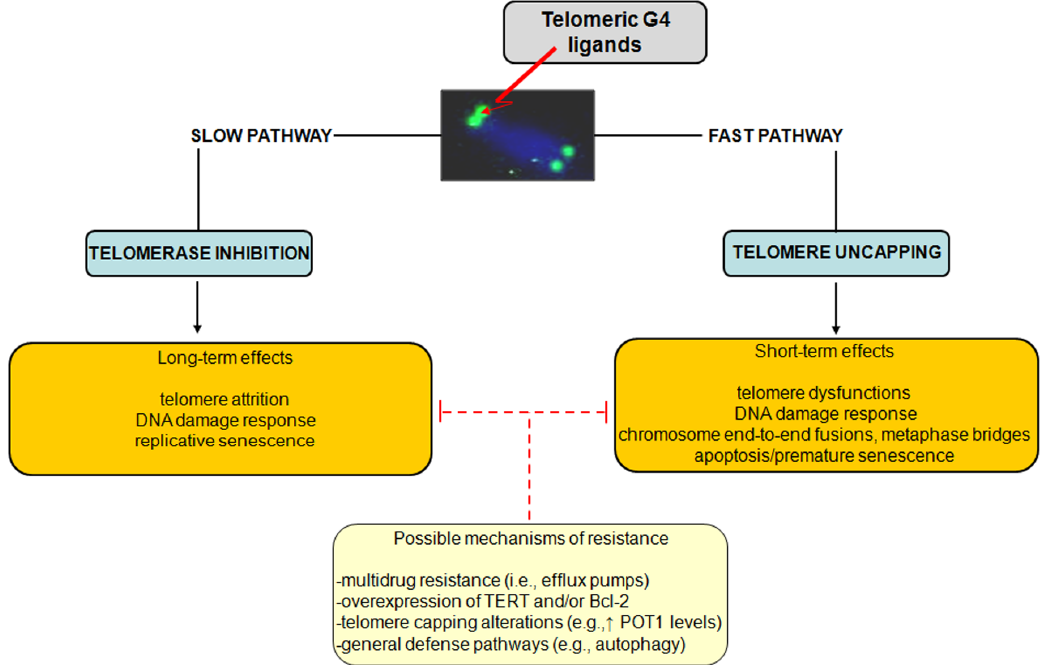
Figure 3. Schematic representation of the dual mechanism of action of telomeric G4 ligands. Possible resistance mechanisms that enable tumor cells to cope with telomeric G4-ligand-mediated detrimental effects have been also